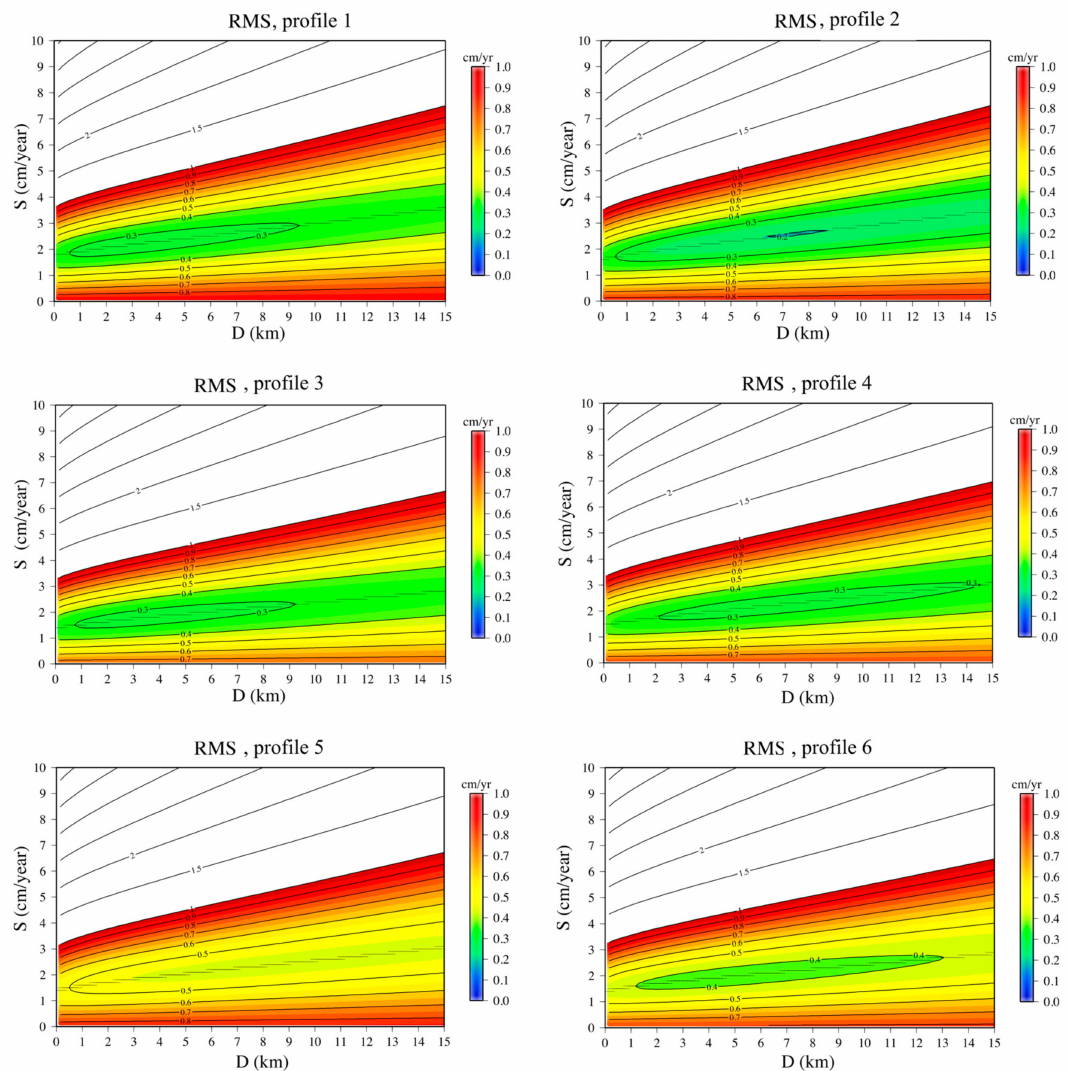
Figure 5. Estimation of the root mean square (RMS) of the residual between the data and the model parameterised by the locking depth (D) and the slip velocity at depth (S) for every profile (ranging from 1 to 6). The RMS is displayed in cm/year. The color code for the RMS is 0 cm/year (dark blue, perfect match) to 1 cm/year (red). The isolines are displayed every 0.1 cm/year between 0–1 cm/year, and then every 0.5